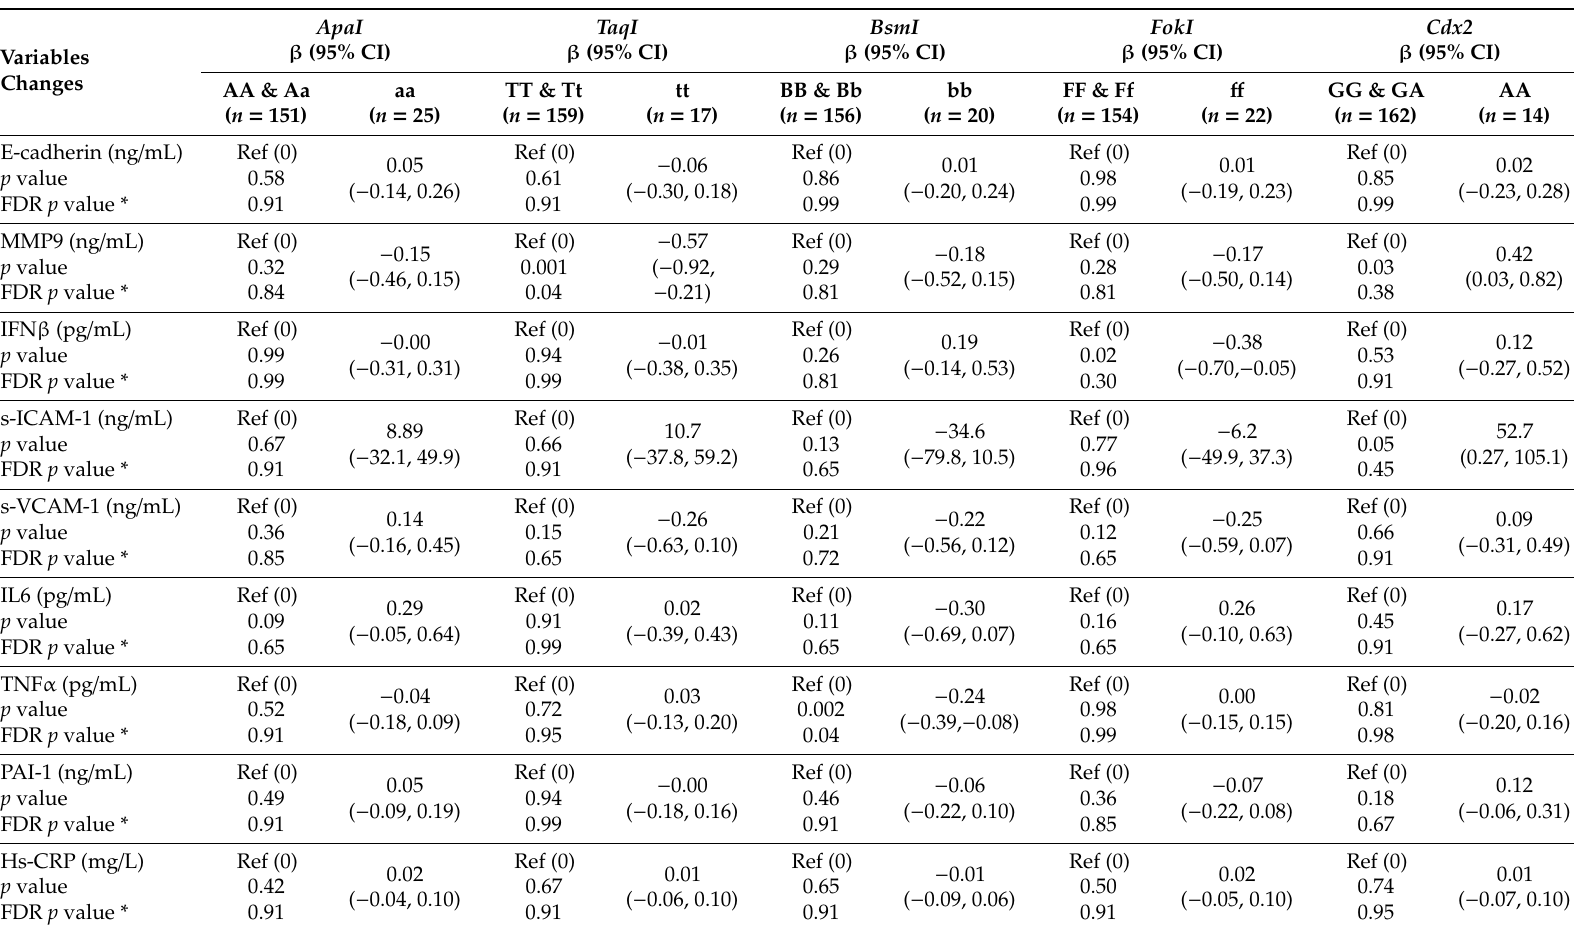
Table 4. Association analyses between VDR SNP genotypes and on-study breast cancer biomarkers changes among patients supplemented with vitamin D3 (4000 IU / day for 12 weeks) under recessive